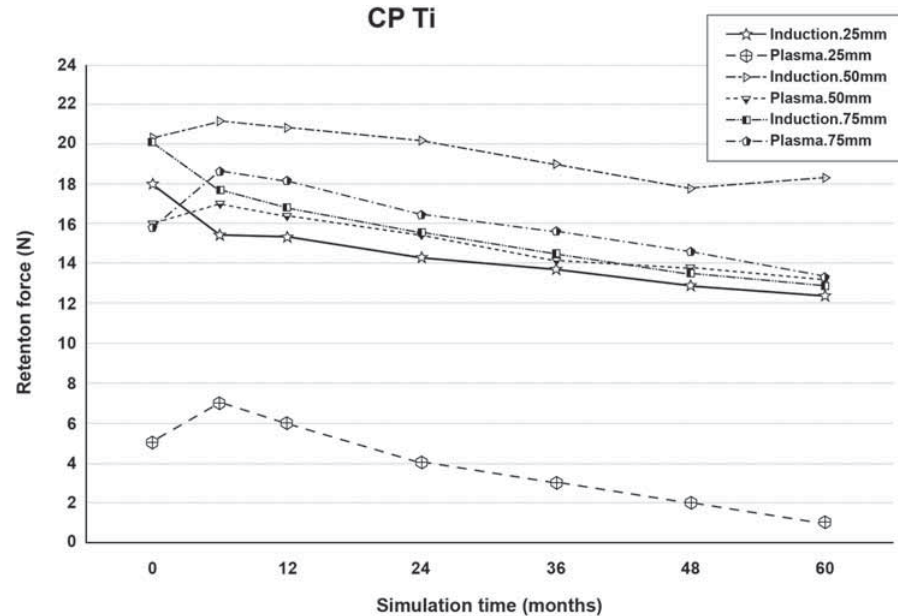
Figure 2- Retention force (N) of CP Ti metallic frameworks for undercut (mm) x casting method (induction/centrifugation or plasma/vacuum-pressure) x time of insertion/removal simulation